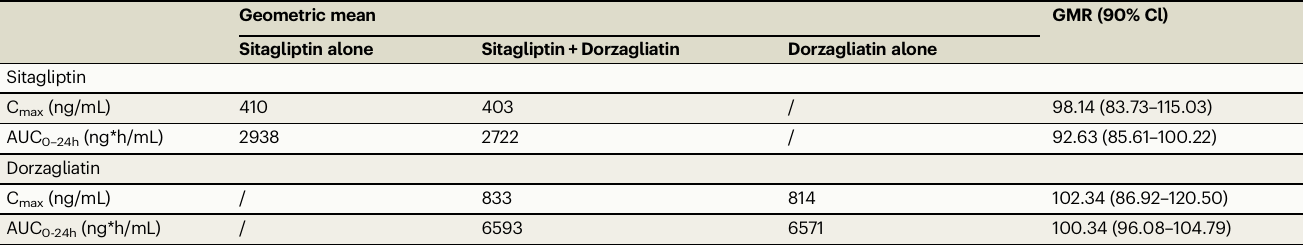
Table 2 | Pharmacokinetic parameters for sitagliptin and dorzagliatin, measured at steady state, after the last dose in a 5-day interval of sitagliptin only, dorzagliatin only, or sitagliptin + dorzagliatin treatment Geometric mean Sitagliptin